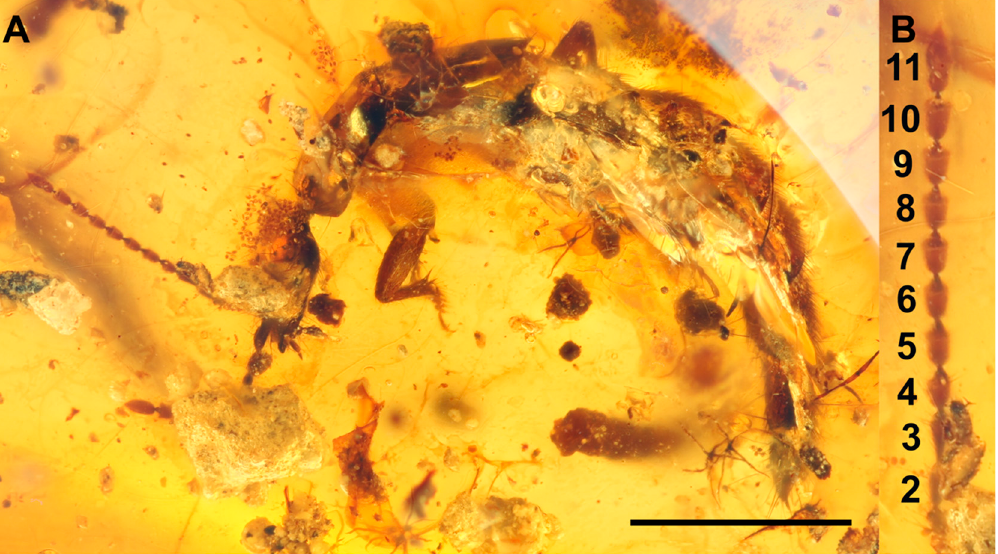
Figure 5. Coomania yini sp. nov. Holotype SNUC-Paleo-0107. ( A ), lateral view. ( B ), antennae. Scale bars = 1 mm.